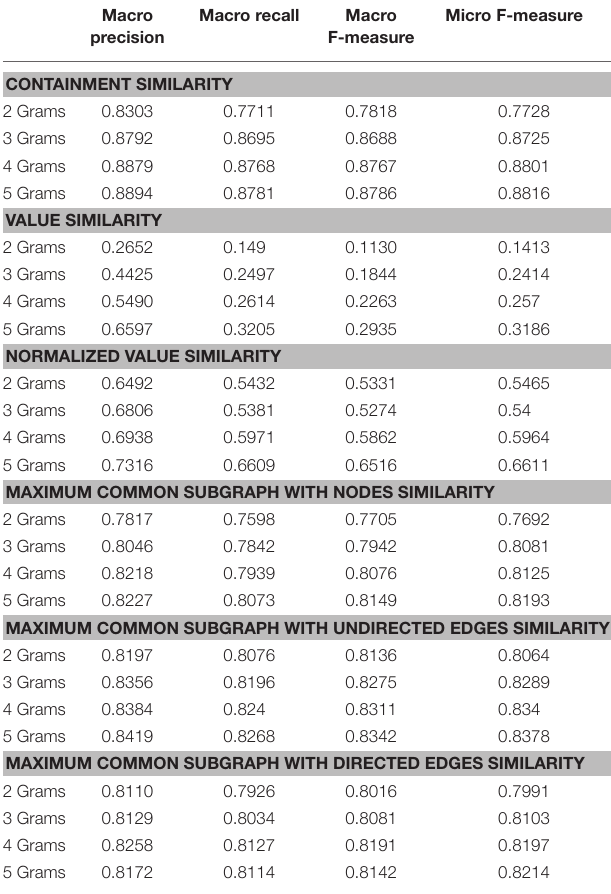
TABLE 1 | Evaluating graph similarity metrics with